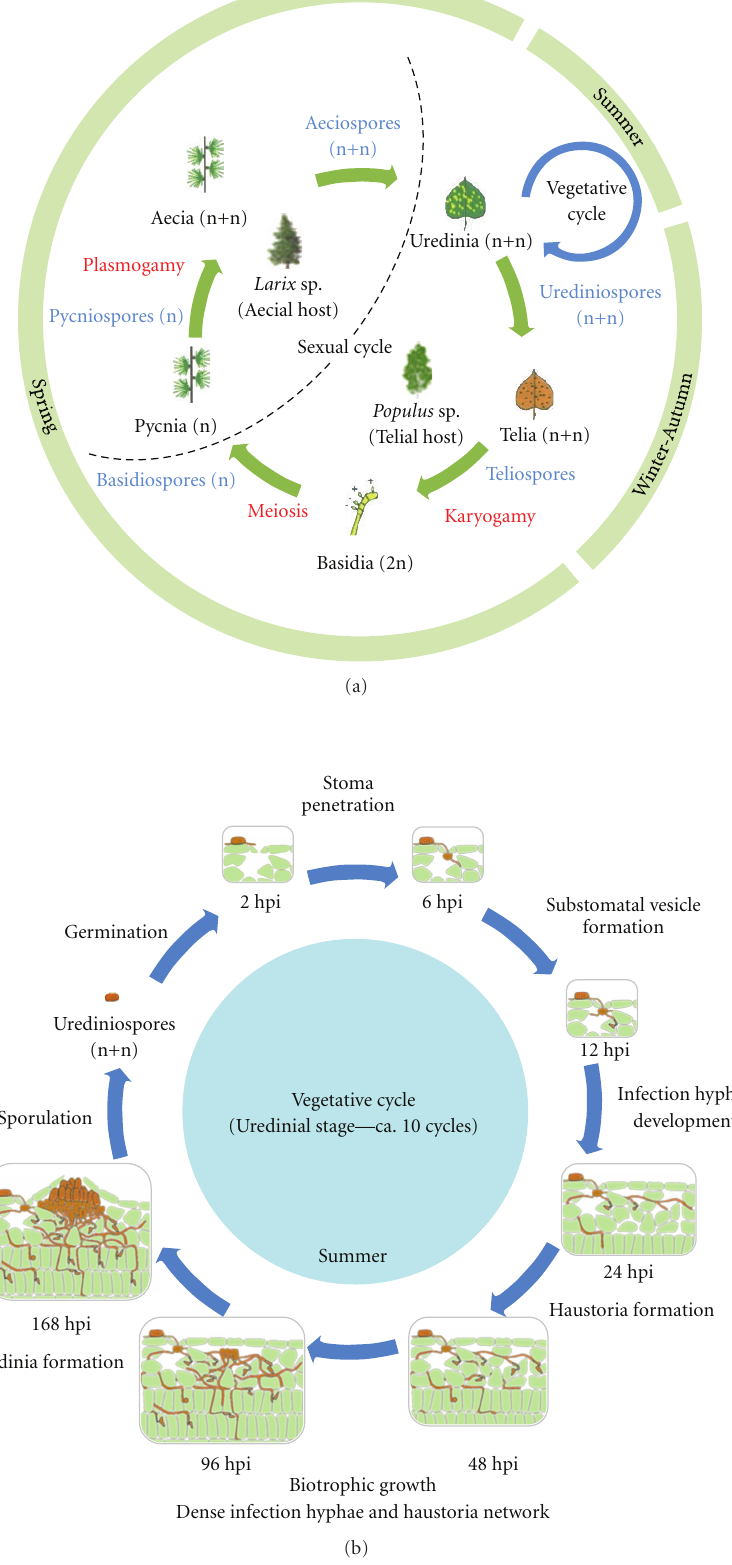
Figure 1: Life cycle of Melampsora larici-populina . (a) Biological macrocyclic heteroecious cycle of M. larici-populina . (b) Vegetative cycle occurring on poplar leaves and used as a model for molecular investigations of the poplar-poplar rust